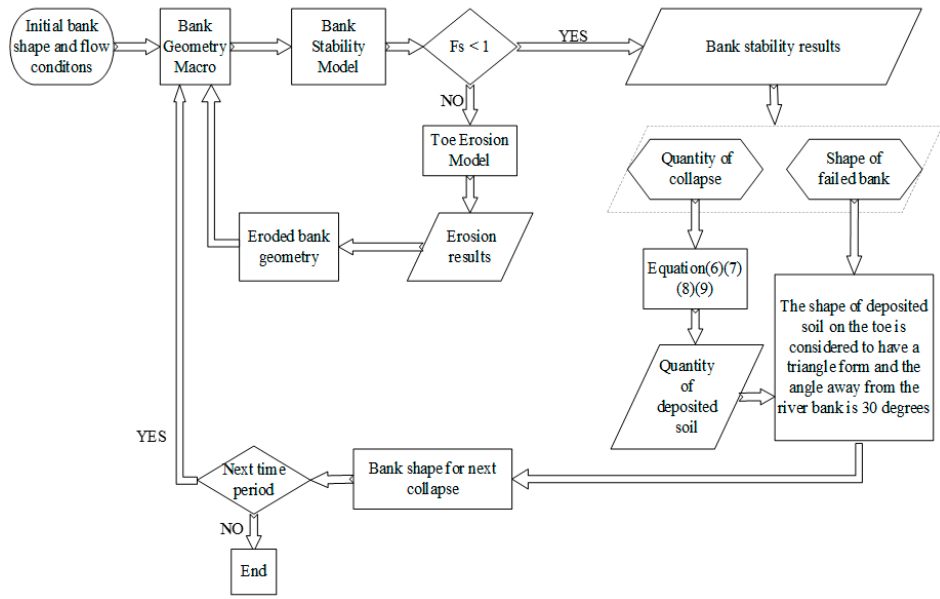
Figure 5. Flow chart of the established model.